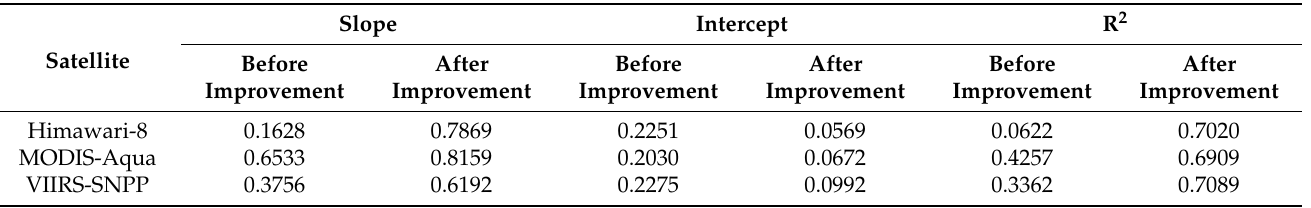
Table 6. Metrics of the linear regression of Chl in situ data and satellite Chl-a data before and after algorithm